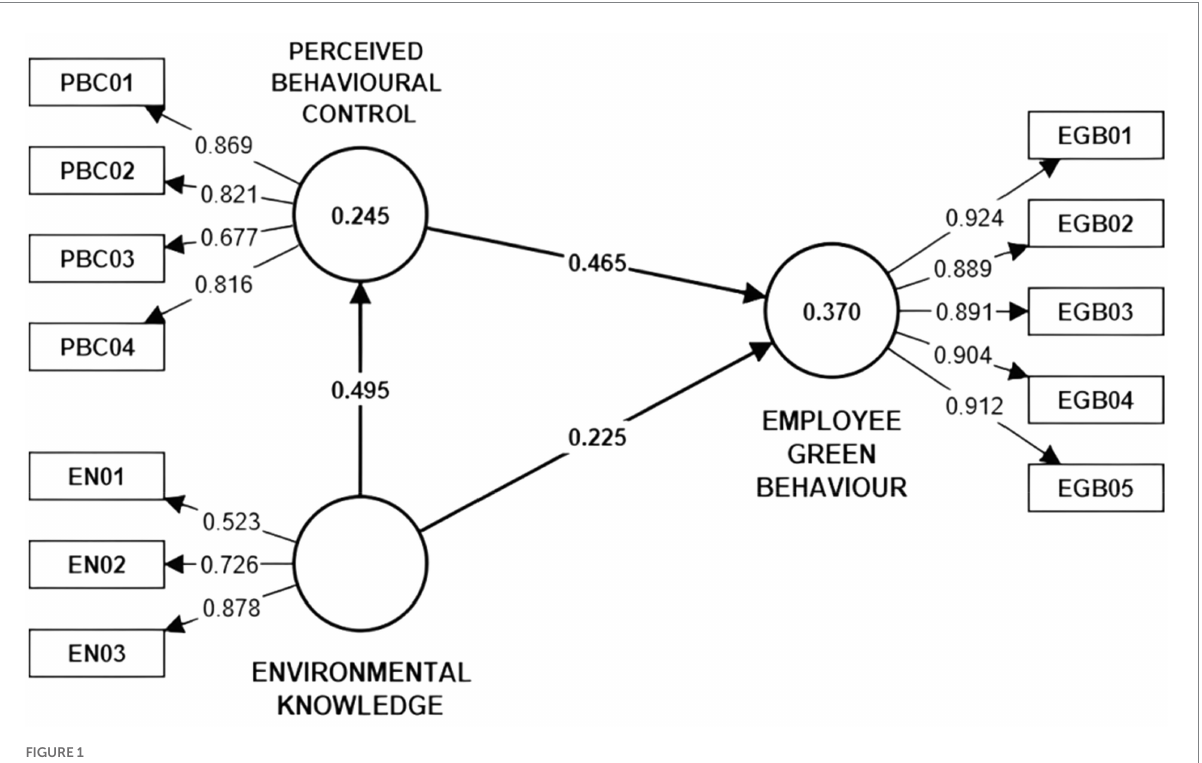
FIGURE 1 Structural model.